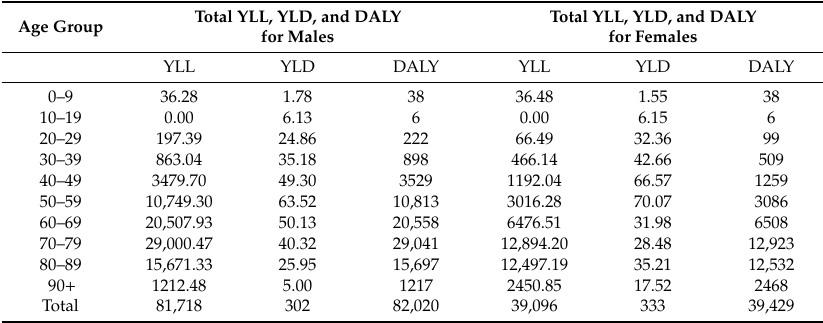
Table 1. Years of lost life (YLL), years lost due to disability (YLD), and disability-adjusted life years (DALY) attributable to COVID-19 stratified by age and gender in Italy. Age